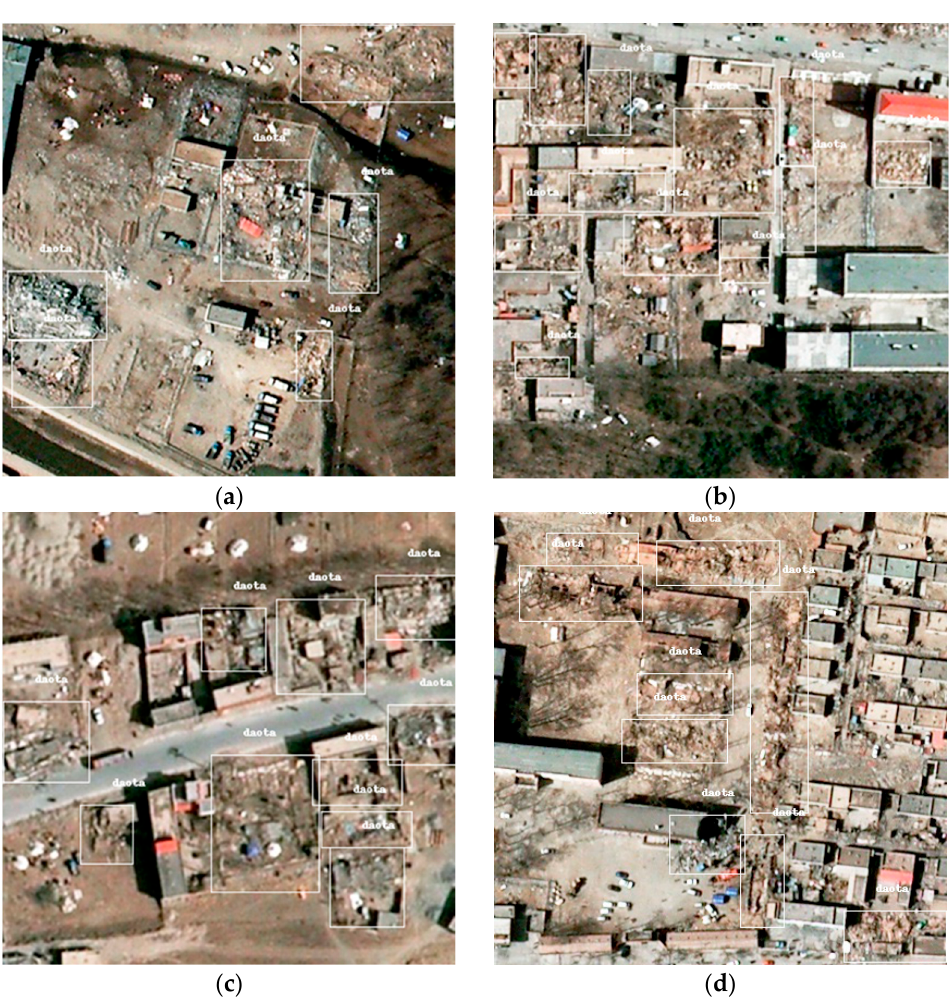
Figure 2. Sample post-earthquake aerial image tag ( a – d ) (white box represents labeled collapsed buildings).